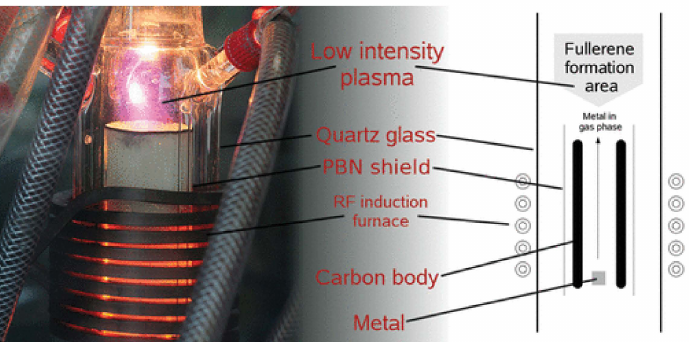
Figure 2. A photograph and model of the production chamber in the RF furnace. Reprinted with permission from [28]. Copyright 2010, American Chemical Society.